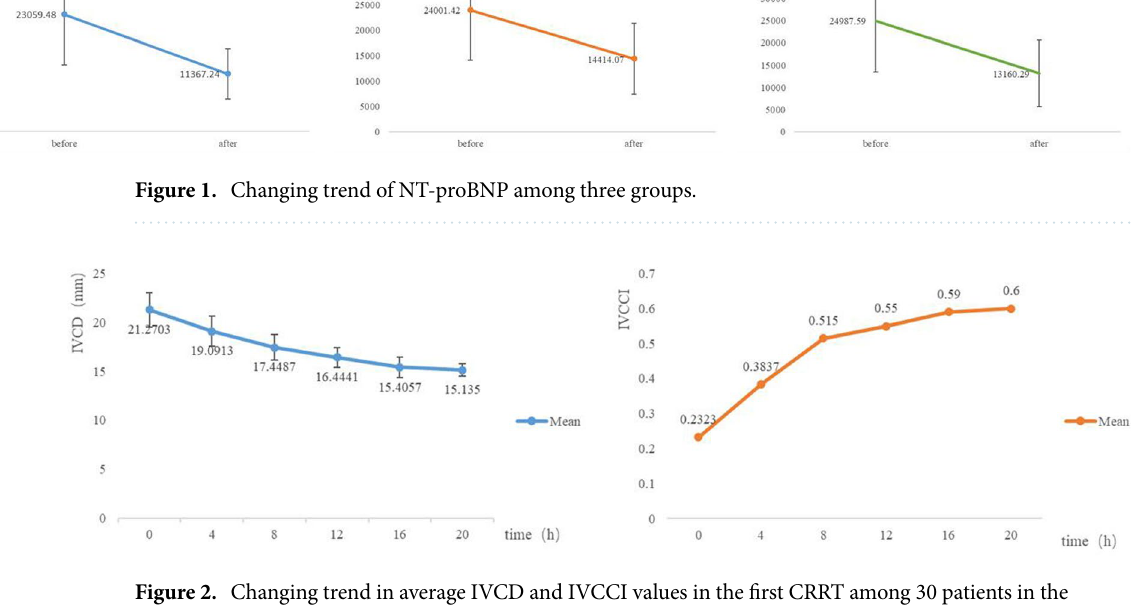
Figure 2. Changing trend in average IVCD and IVCCI values in the first CRRT among 30 patients in the ultrasound group after ICU